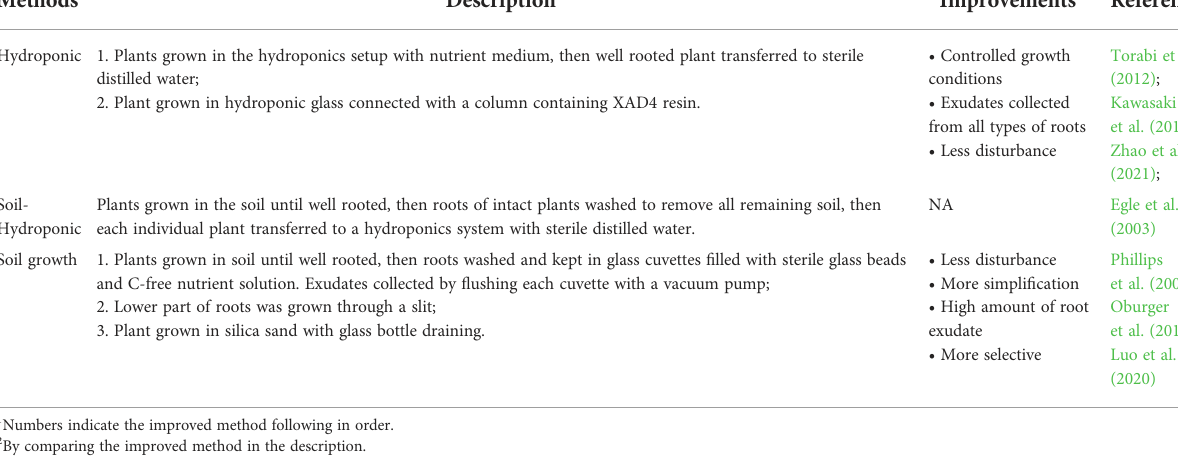
TABLE 1 The approaches for the root exudates collection and